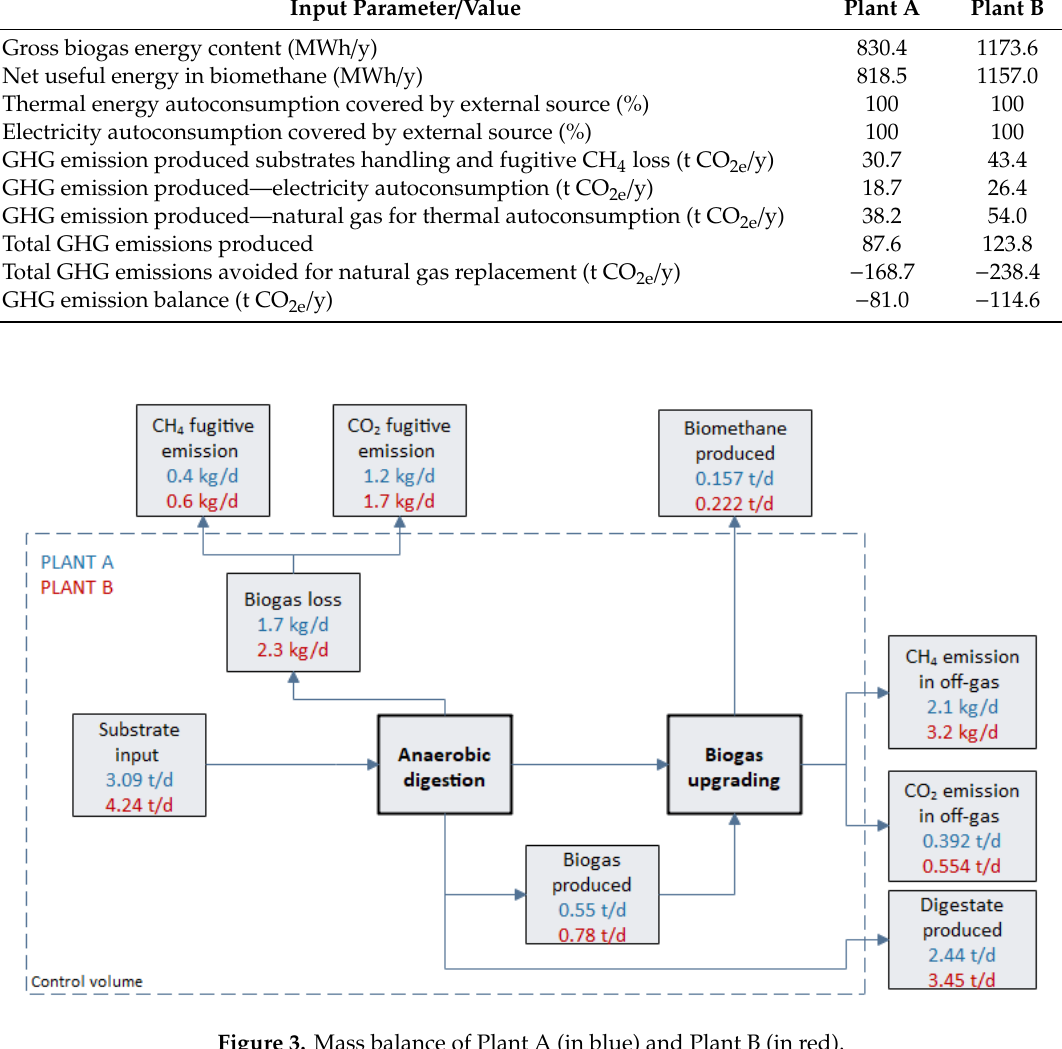
Figure 3. Mass balance of Plant A (in blue) and Plant B (in red).